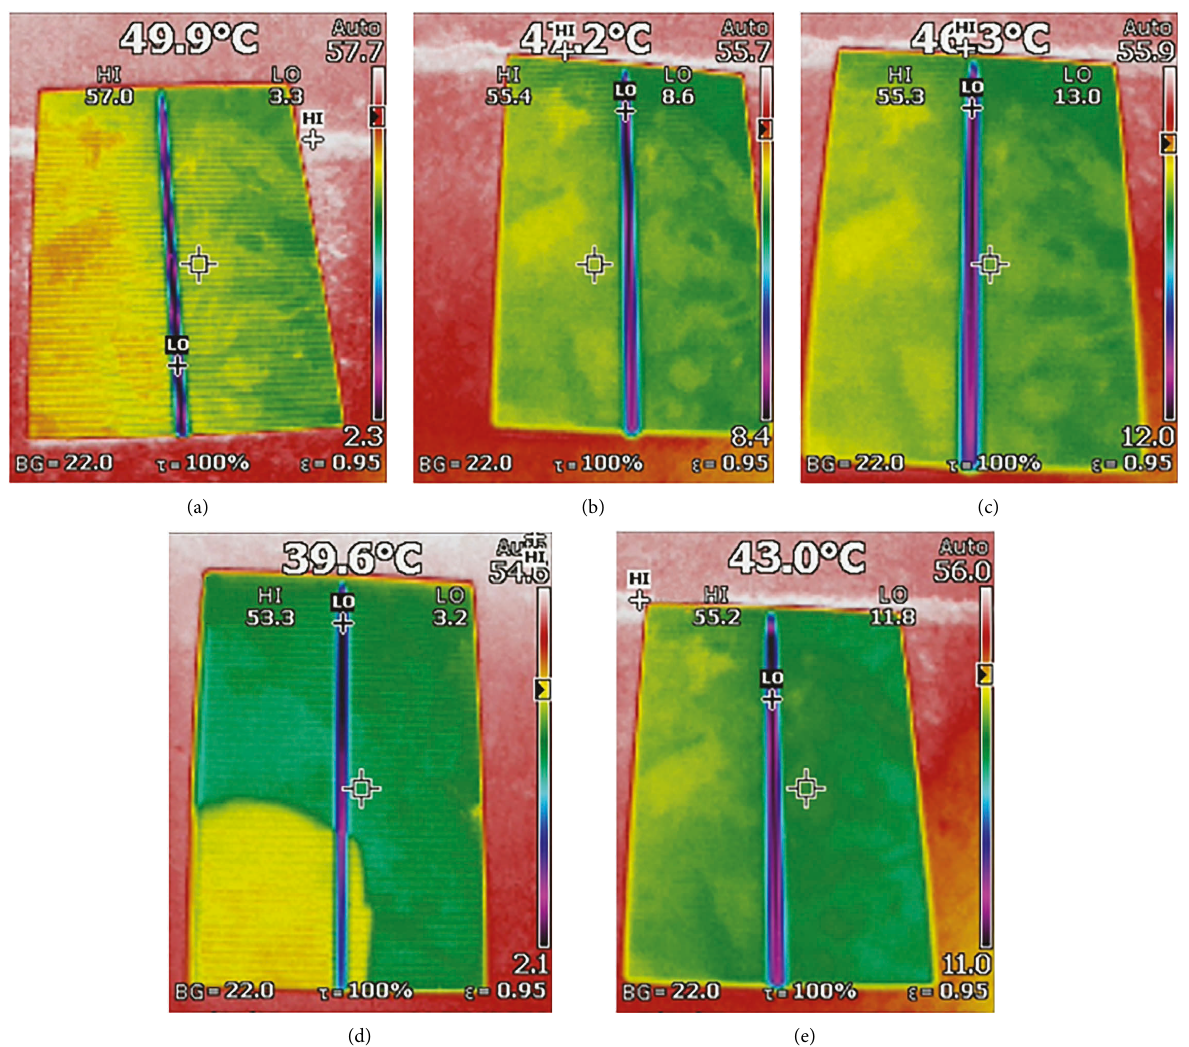
Figure 12: Thermal analysis under direct sunlight: (a) B-I (uncoated), (b) B-II (SiO (SiO 2 /TiO 2